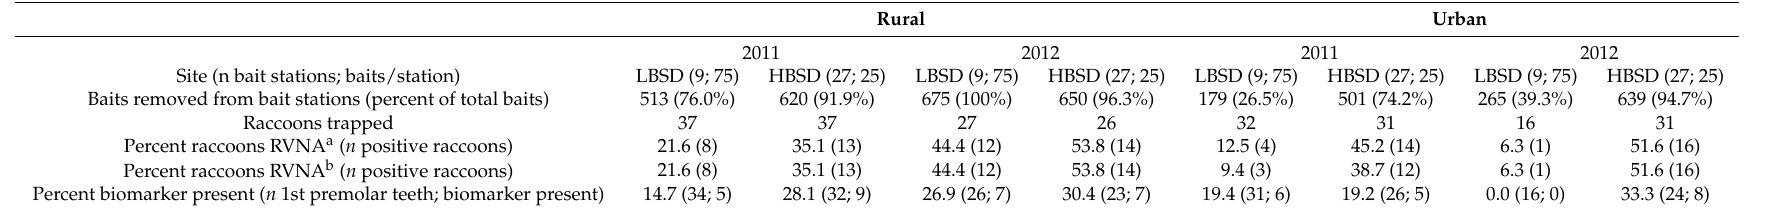
Table 1. Bait station study area designs and results for 2011 and 2012 in rural and urban sites in